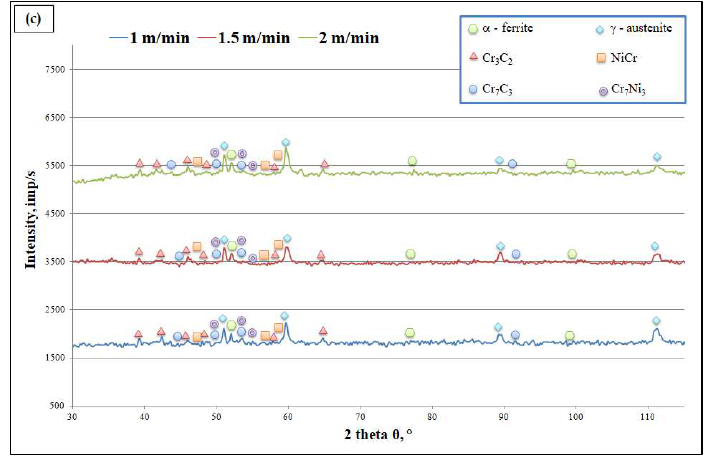
Figure 14. Diffractograms after laser alloying process for ( a ) sample 1, ( b ) sample 2, and ( c ) sample 3.